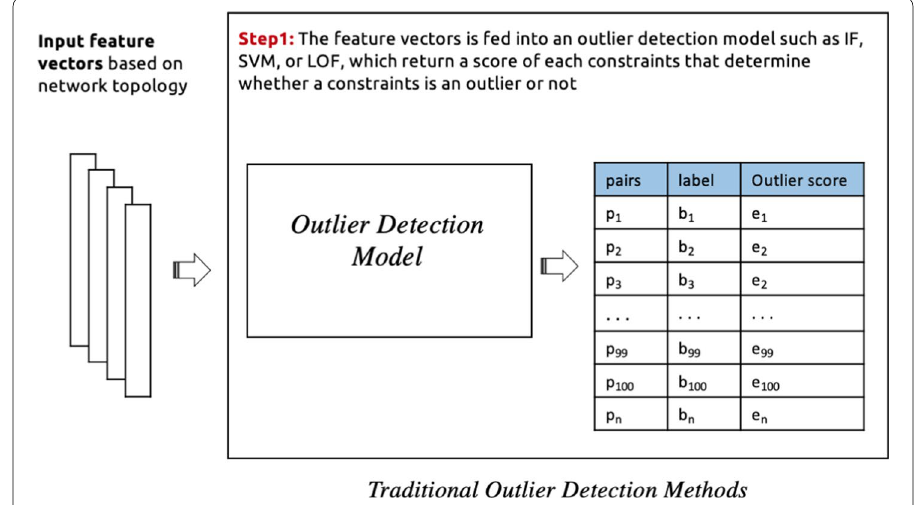
Fig. 3 An illustration of the process for identifying noisy pairwise constraints using traditional outlier detection